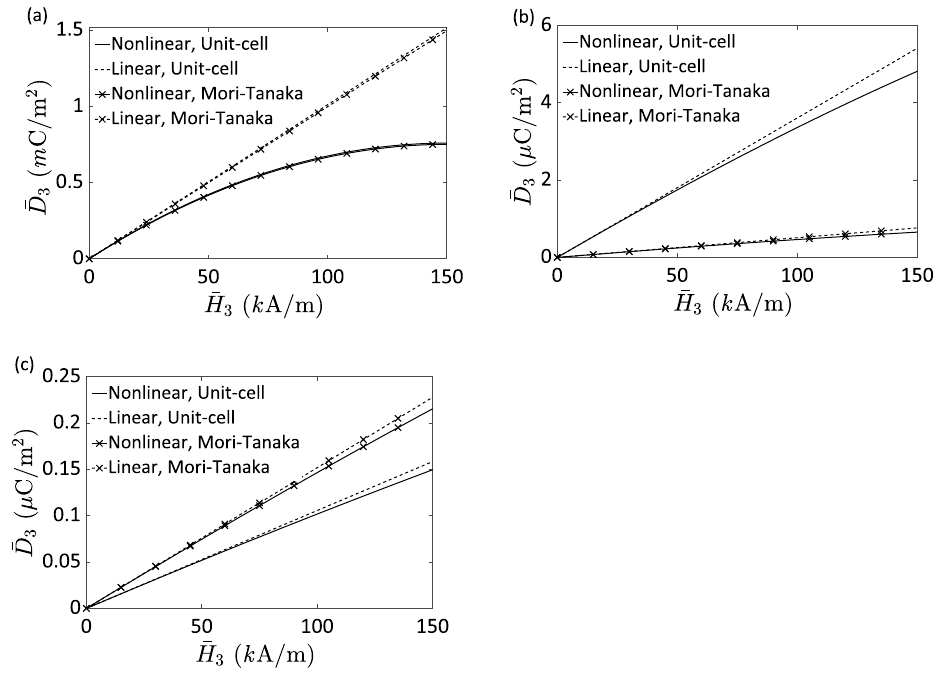
Figure 5. Effective electric displacement D 3 as a function of an applied magnetic field H 3 for a stress-free Terfenol-D/PZT G-1195/Araldite D composite with the corresponding phase volume fractions of 0.25/0.25/0.5 having 1–3 ( a ), 0–3 ( b ), and 2–2 ( c ) connectivities,